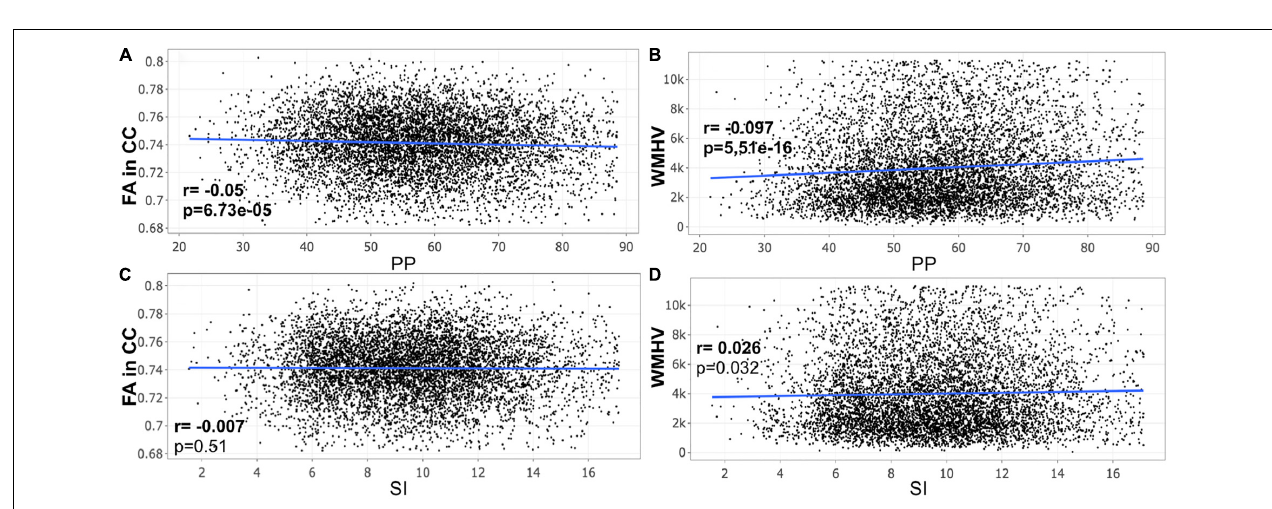
FIGURE 3 | Scatter plot for partial correlation analysis of either pulse pressure (PP) or stiffness Index (ASI) with the fractional anisotropy of the corpus callosum (FA in CC) or the white matter hyperintensity volume (WMHV) in 6,875 participants between 65 and 75 years old. Significant p -values are in bold (adjusted threshold with FDR was 0.0375). Covariates included sex. An additional analysis was performed with both age and sex as covariates showing similar significant results: (A) p = 2.03e-05; (B) p = 6.73e-33; (C) p > 0.0375; (D) p =